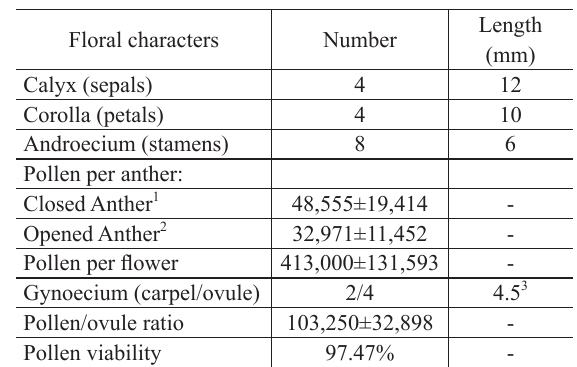
Characteristics of the flowers of Rizhophora mangle (Rhizophoraceae) in the northern coast of Pernambuco, Brazil. 1 Anthers removed from young buds; 2 anthers removed from pre-anthesis buds; 3 height of the